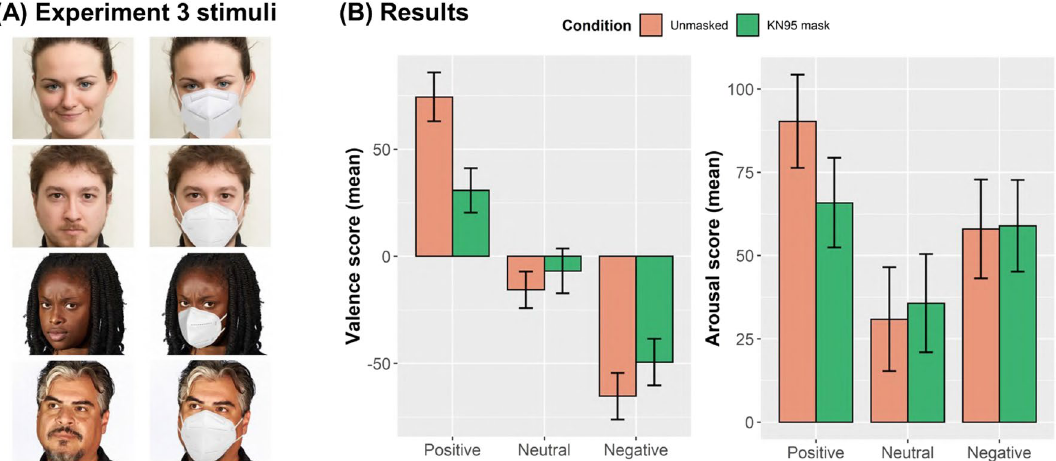
Figure 3. Experiment 3 stimuli and results. ( A ) The same 45 mental states used in Experiments 1 and 2 were selected for each of four different actors, for a total of 180 unmasked stimuli and 180 masked stimuli. ( B ) When combining all actors together, mean valence scores decreased significantly in valence when comparing unmasked and masked faces for positive mental states, but increased significantly in valence for the neutral and negative categories. Furthermore, there was a significant decrease of perceived arousal scores for positive mental states. Error bars represent standard deviation of the